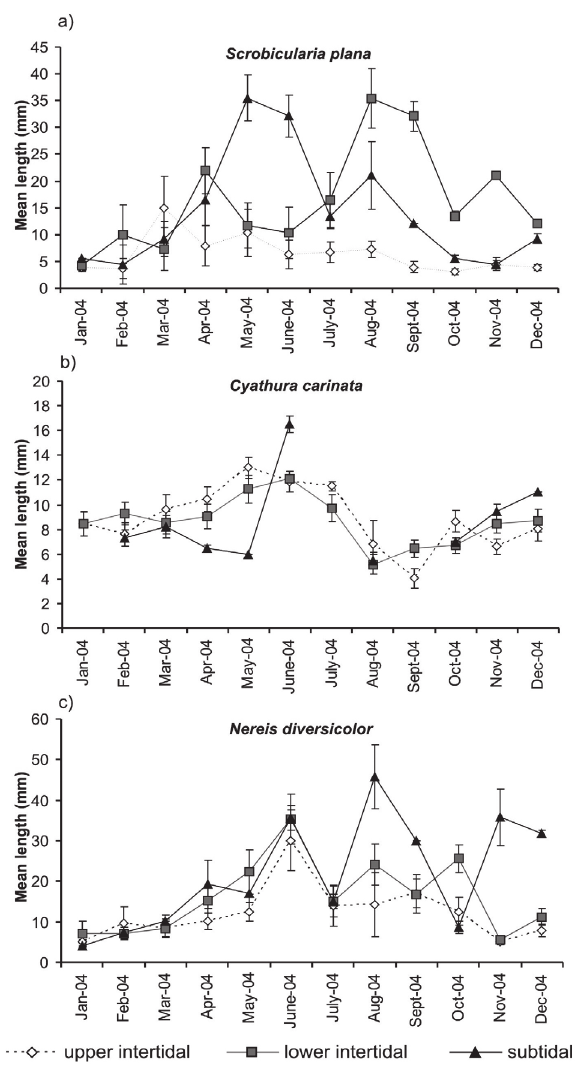
Fig . 4. – Spatial and seasonal variation pattern of individual mean total length (mm) (and standard errors) for S. plana (a) , C. carinata (b) and N. diversicolor (c)